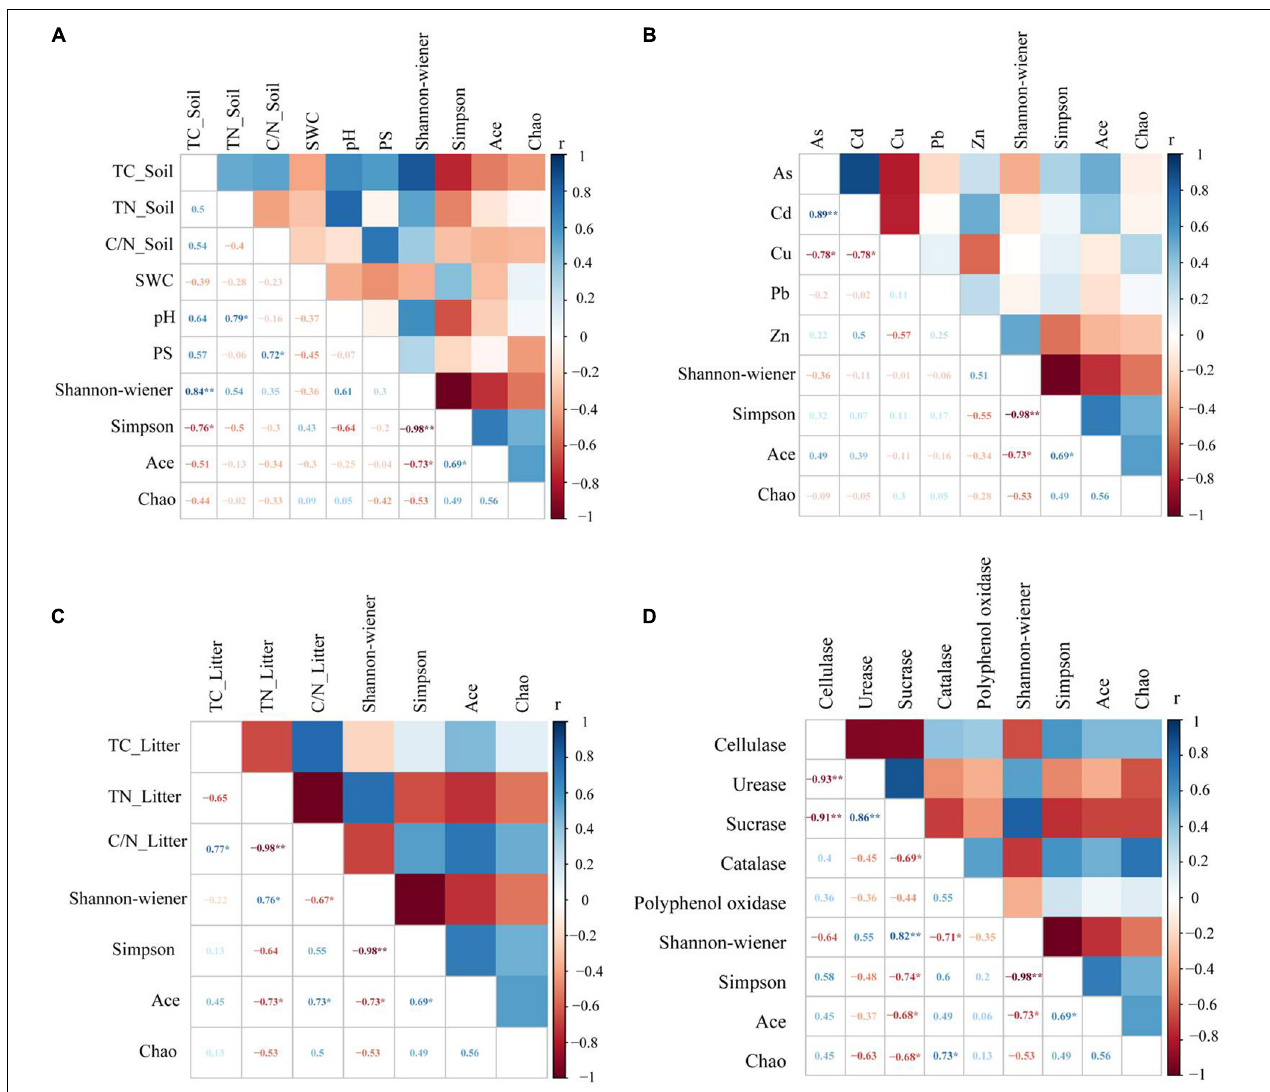
FIGURE 4 | Correlations between environmental factors and bacteria diversity in litter. Environmental factors include soil properties (A) , heavy metals (B) , litter properties (C) , and litter enzyme activities (D) . Soil properties include total carbon (TC_Soil), total nitrogen (TN_Soil), the carbon and nitrogen ratio (C/N_Soil), pH, soil water content (SWC) and average particle size (PS). Litter properties include total carbon (TC_Litter), total nitrogen (TN_Litter) and the carbon and nitrogen ratio (C/N_Litter), while litter enzyme activities include cellulase, urease, sucrase, catalase and polyphenol oxidase. *Correlations are significant at a level of 0.05 (two-tailed); **correlations are significant at a level of 0.01